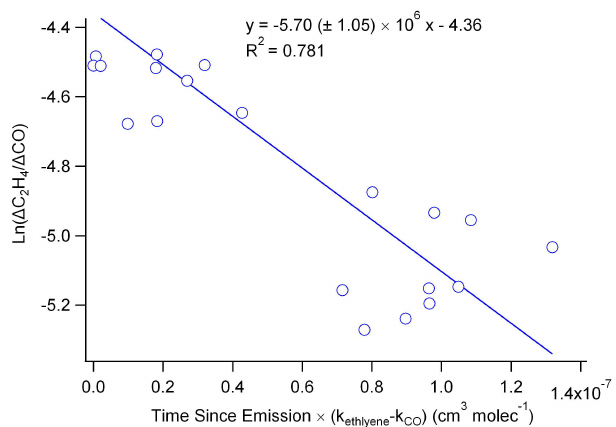
Fig. 7. Increase in 1 CH 3 COOH/ 1 CO (blue) and 1 HCOOH/ 1 CO (green) vs. time since emission (h). Individual source samples are not shown and we instead show ERs (solid blue and solid green circles, respectively) with an error bar reflecting the standard devia- tion in the mean of the ten source measurements. The ER(HCOOH) error bar is too small to be visible. Downwind error bars are an esti- mate of the uncertainty in the oldest individual downwind